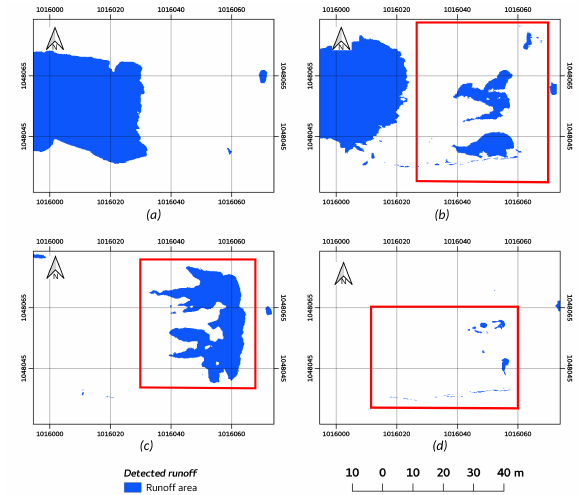
Figure 10. Detected elevation changes from NDEI for time periods under study: (a) January-February; (b) February-March; (c) March-April; and (d) April-May. Surface runoff areas are enclosed by red